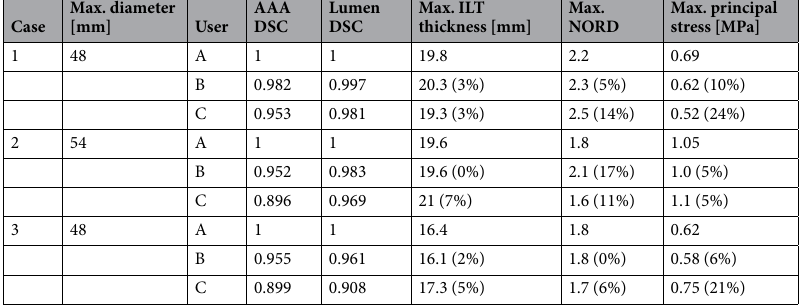
Table 1. Reproducibility of analysis results. The relative differences between the results of users B and C and user A are shown in parenthesis. NORD = normalized